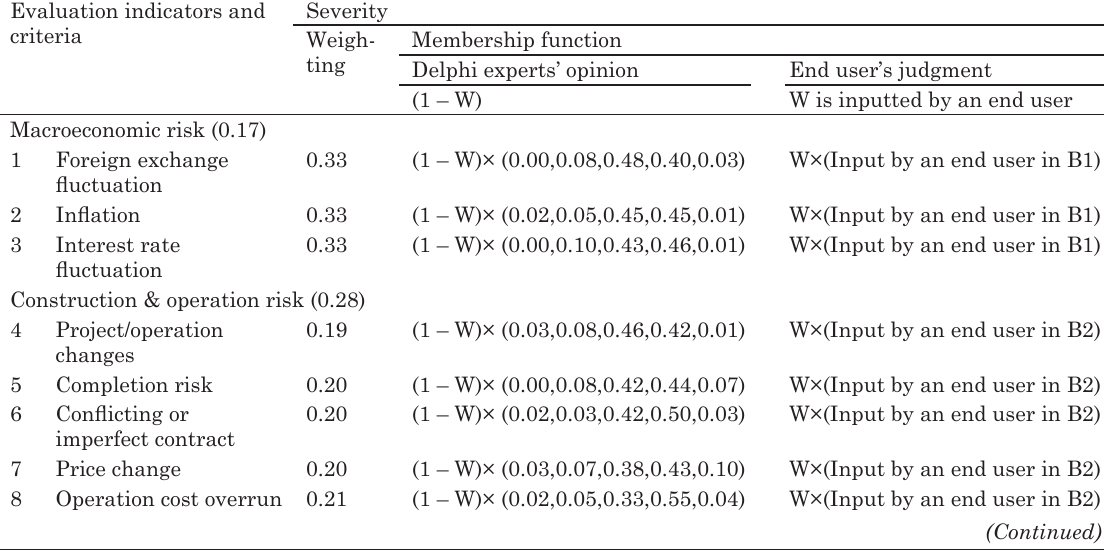
table 6. the weighting and membership function for severity of each risk indicator and risk criterion evaluation indicators and